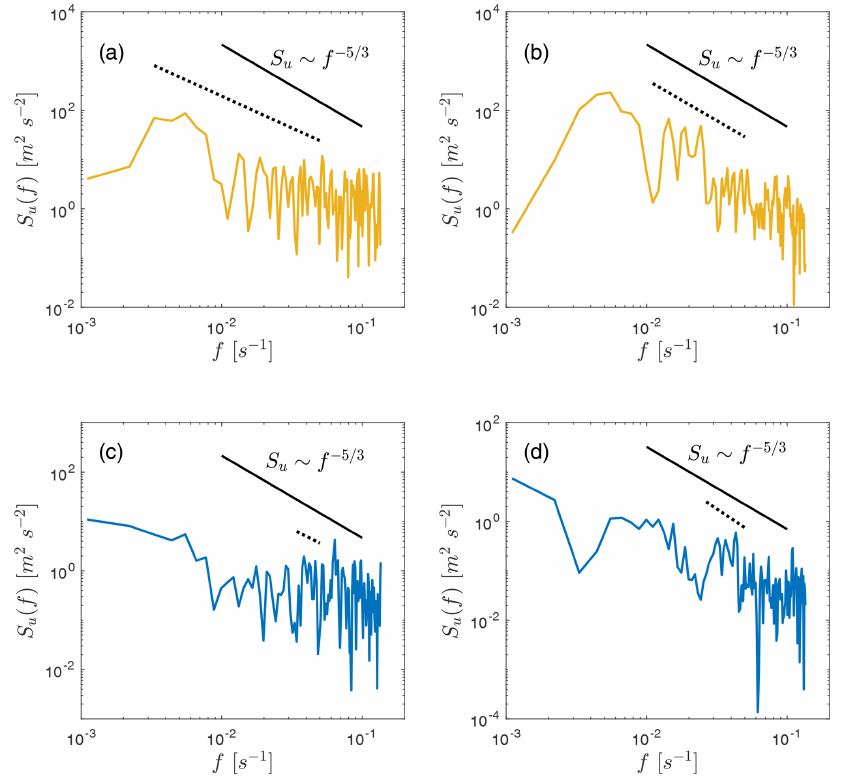
Figure 2. Example of smoothing spline fit of an experimental spectrum of the line-of-sight velocity measured by one beam of the WC49 (a, c) and WC68 (b, d) lidars at 120m above the surface. The top panels represent daytime conditions on 14 July 17:30UTC, and the bottom panels represent nighttime conditions on 14 July 07:00UTC. Turbulence dissipation at this time was 643 × 10 − 3 m 2 s − 3 for the WC49 and 615 × 10 − 3 m 2 s − 3 for the WC68. The solid black line shows the theoretical − 5 / 3 slope of the spectrum in the inertial subrange. The dotted black line shows the slope of the power fit to the spectrum, starting from the transition frequency and ending at 0.05Hz.